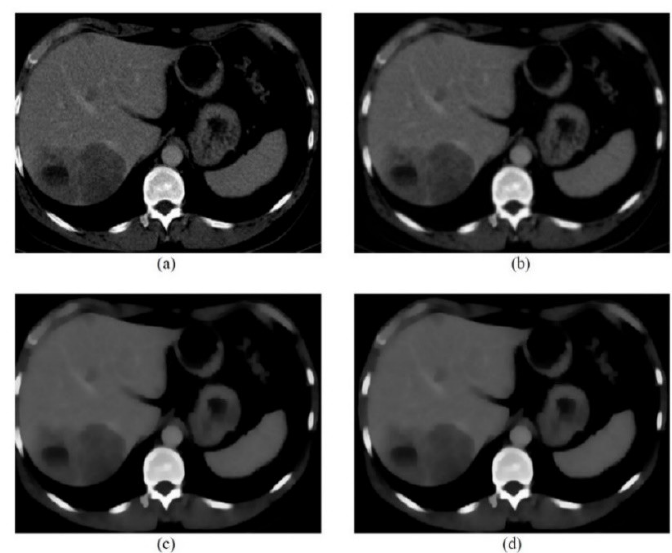
Figure 7. Noise reduction from a Computer Tomography (CT) image. ( a ) Input noisy image. ( b ) Output image, using Daubechies scale filter order 2 (db2). ( c ) Output image, using Daubechies scale filter order 4 (db4). ( d ) Output image, using Haar wavelet [76].